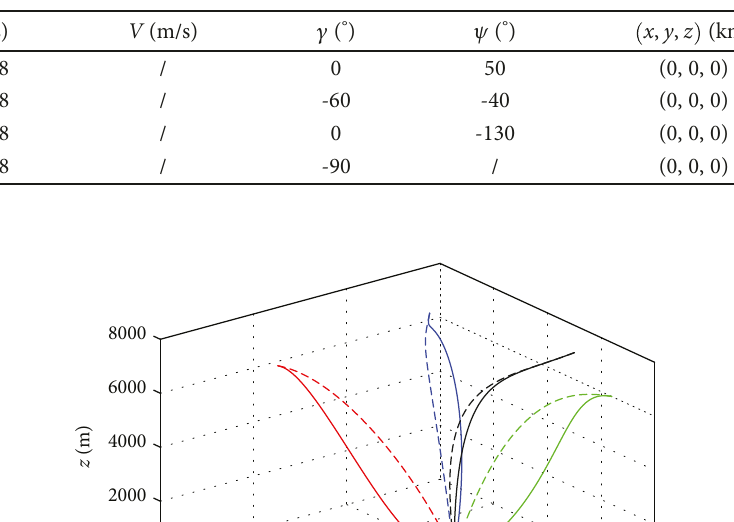
Table 4: Terminal constraints with impact time and angle control.